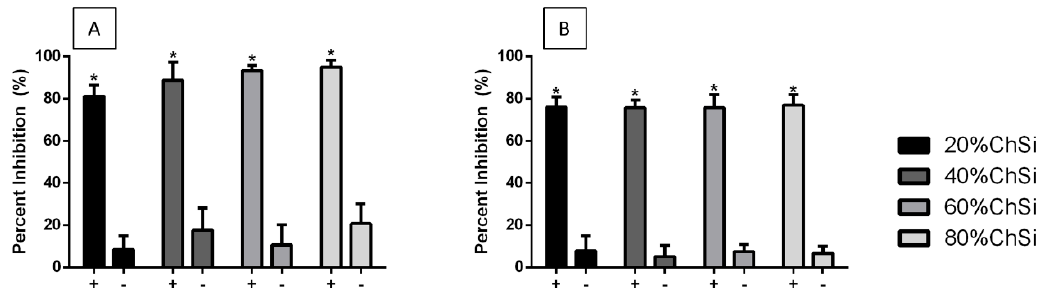
Figure 13. Inhibition of bacterial cultures by hybrid coatings with ( + ) and without ( − ) AgNPs. ( A ) E. coli and ( B ) S. aureus cultures were inhibited by incubation (24 h) with all hybrid coatings, compared to uncoated titanium (Ti6Al4V) controls. There was little inhibition from base coatings without AgNPs, but significantly ( p < 0.05) more and almost total inhibition for coatings loaded with AgNPs.